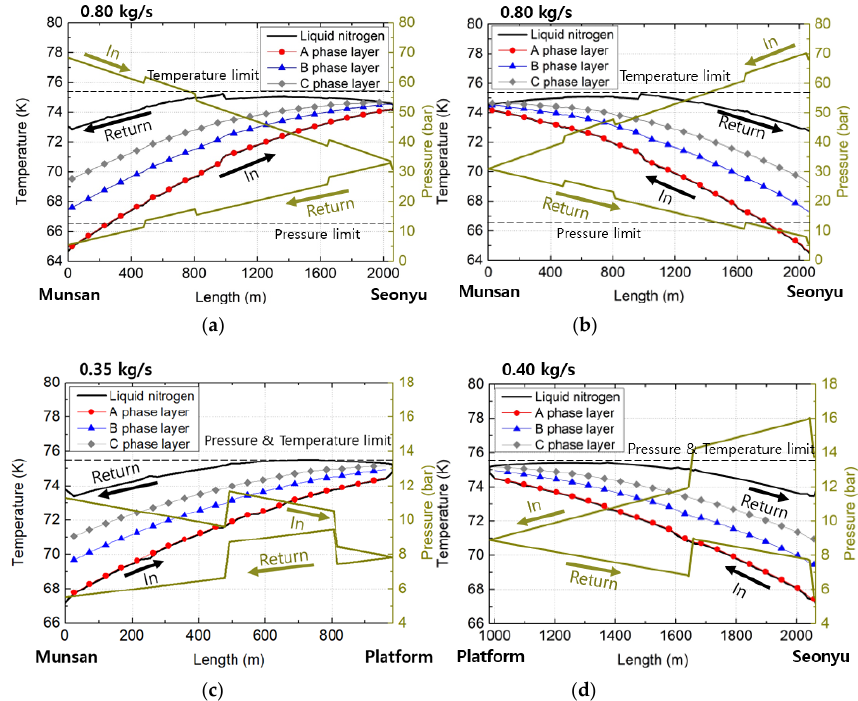
Figure 11. Temperature and pressure result at the position of internal return path: ( a ) single cooling system at Munsan; ( b ) single cooling system at Seonyu; ( c ) dual cooling system on the Munsan side; ( d ) dual cooling system on the Seonyu side.